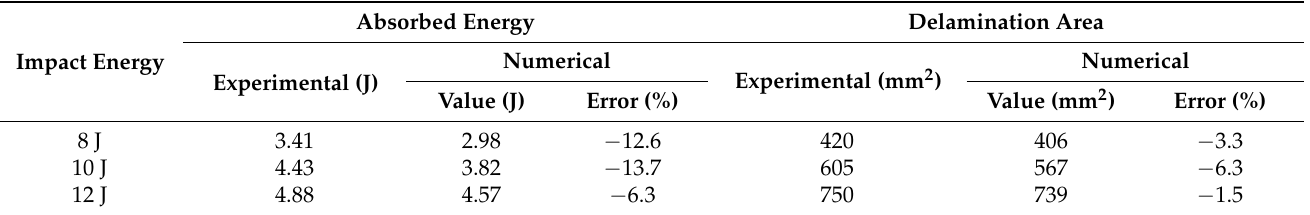
Table 3. Comparison of the experimental and numerical absorbed energies and projected delamina- tion areas